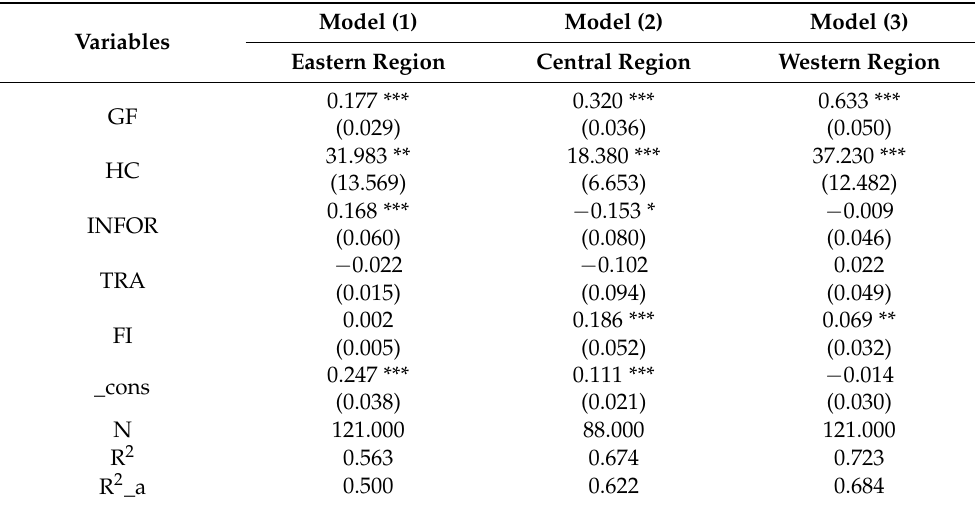
Table 9. Regional empirical tests of green finance for quality economic